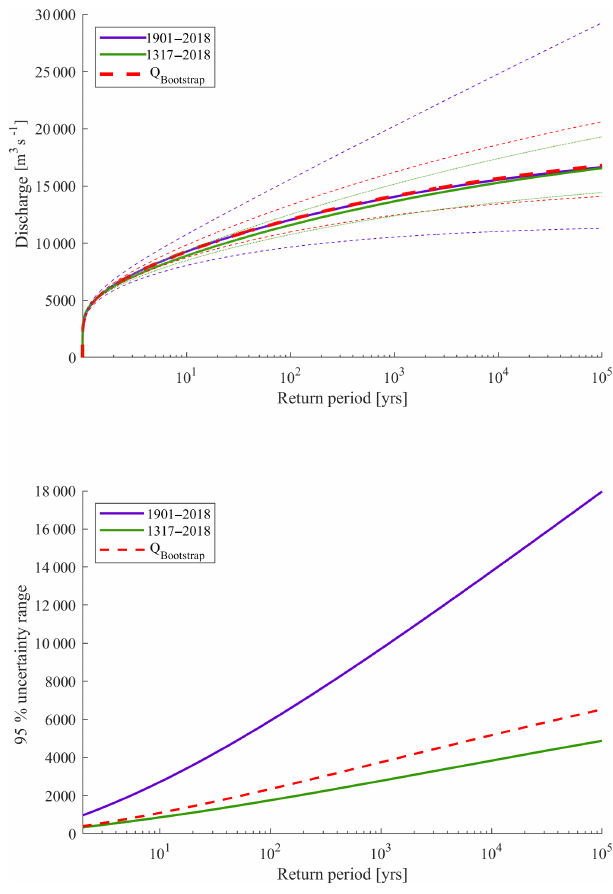
Figure 8. Fitted GEV curves of the 1901, 1317, and Q_Bootstrap data